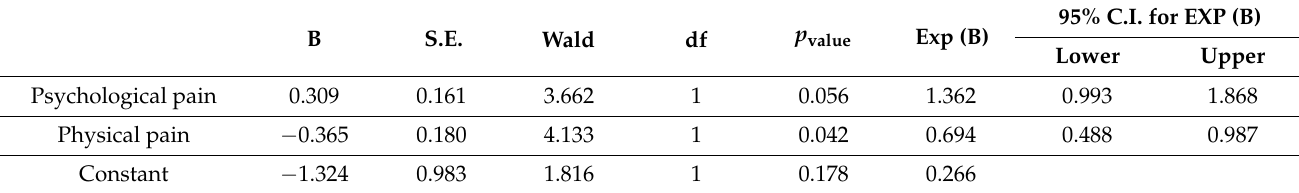
Table 4. Binary logistic regression with respect to patient gender.